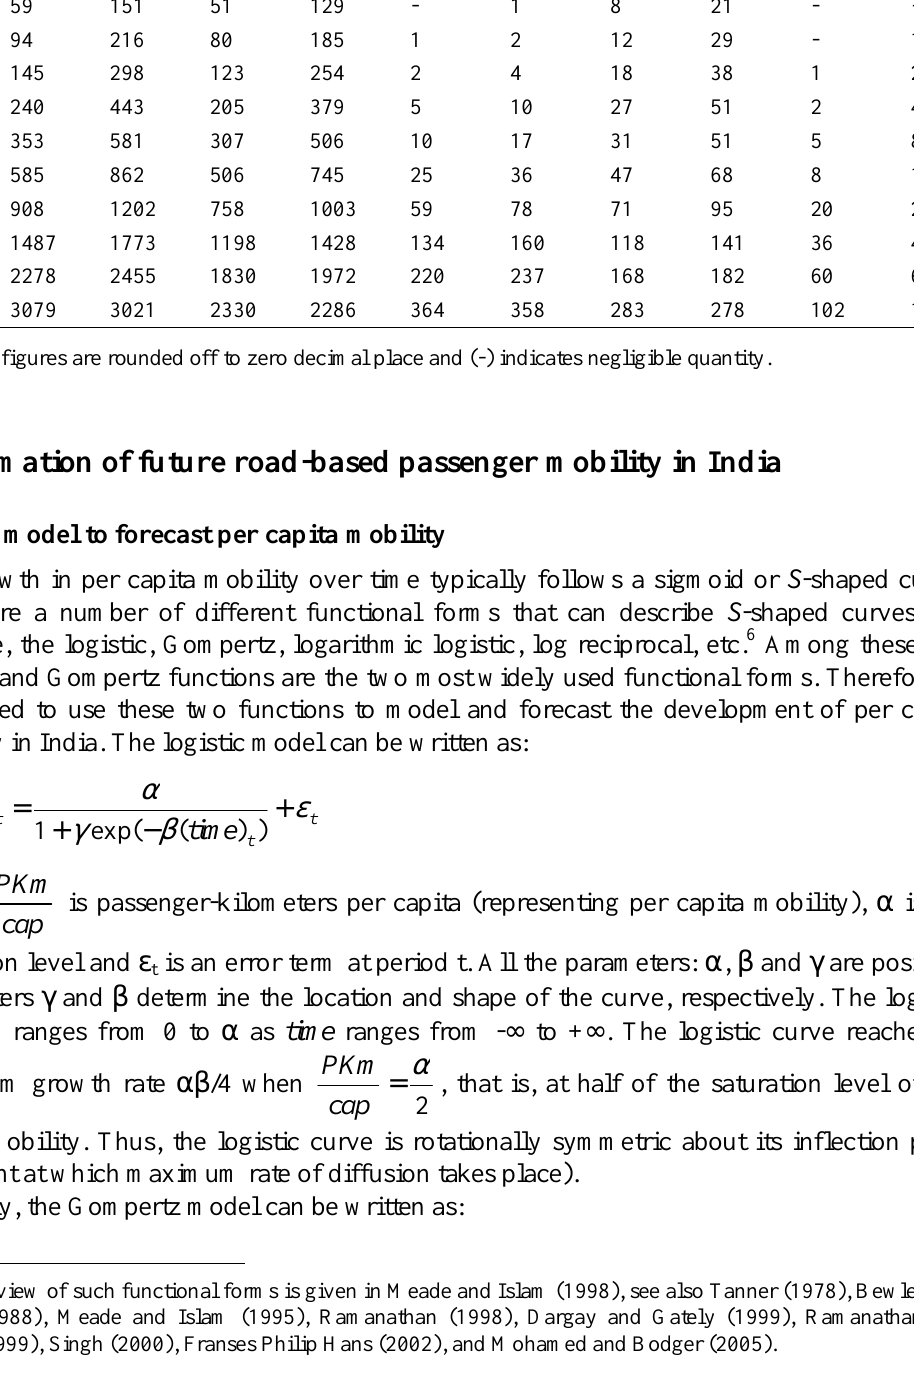
Table 1. Absolute as well as per capita mobility in India BPKm (Road)